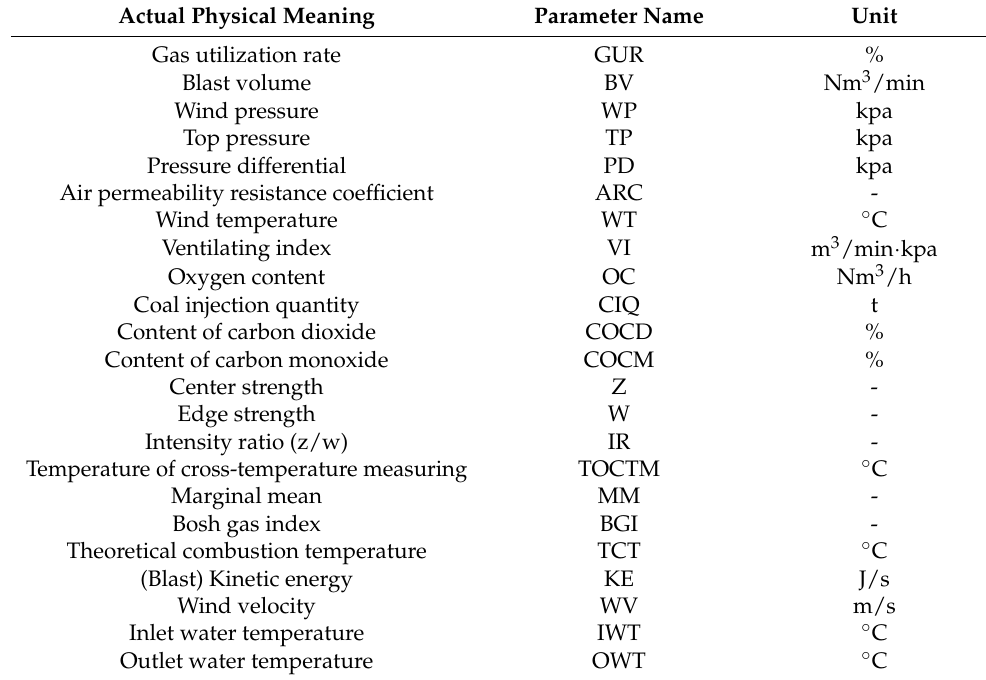
Table 1. The related parameters involved in the